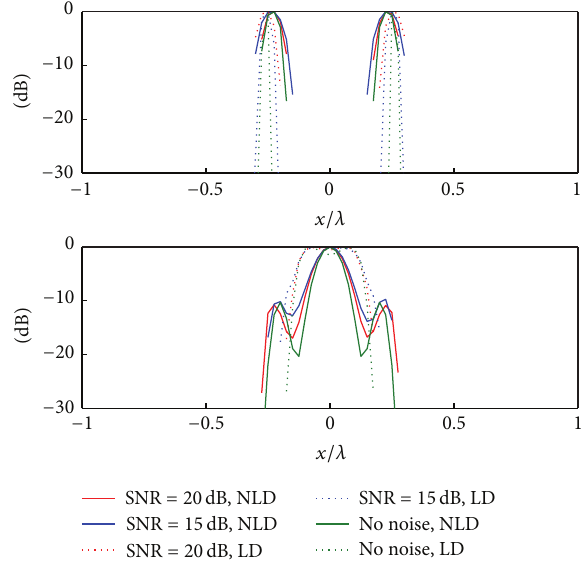
Figure 10: Analysing two-point resolution for CS. Cut view along the 𝑥 -axis of the normalised CS